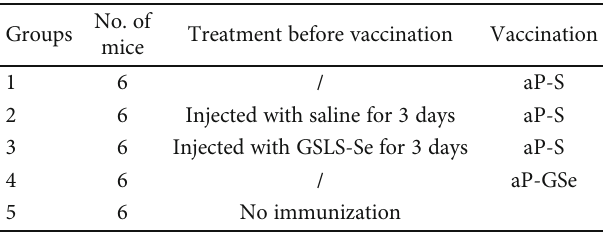
Table 3: Design of experiment B in Section 2.12. No. of Groups